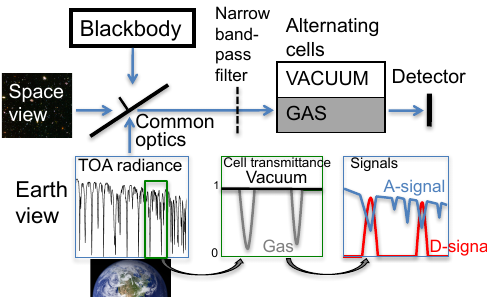
Figure 4. Simplified depiction of the CHRONOS GFCR measure- ments to show how average ( A ) and difference ( D ) signals are generated from spectrally correlated, band-integrated radiance mea- surements through the vacuum ( V ) and gas ( G ) cells. Upwelling atmospheric radiance passes through a narrow band-pass filter, se- lected for the target gas spectral range; through a target gas cell; and on to a detector pixel. For CHRONOS, within 60ms, the at- mospheric radiance passes through an identical band-pass filter, an identical reference vacuum cell, and falls on the same detector